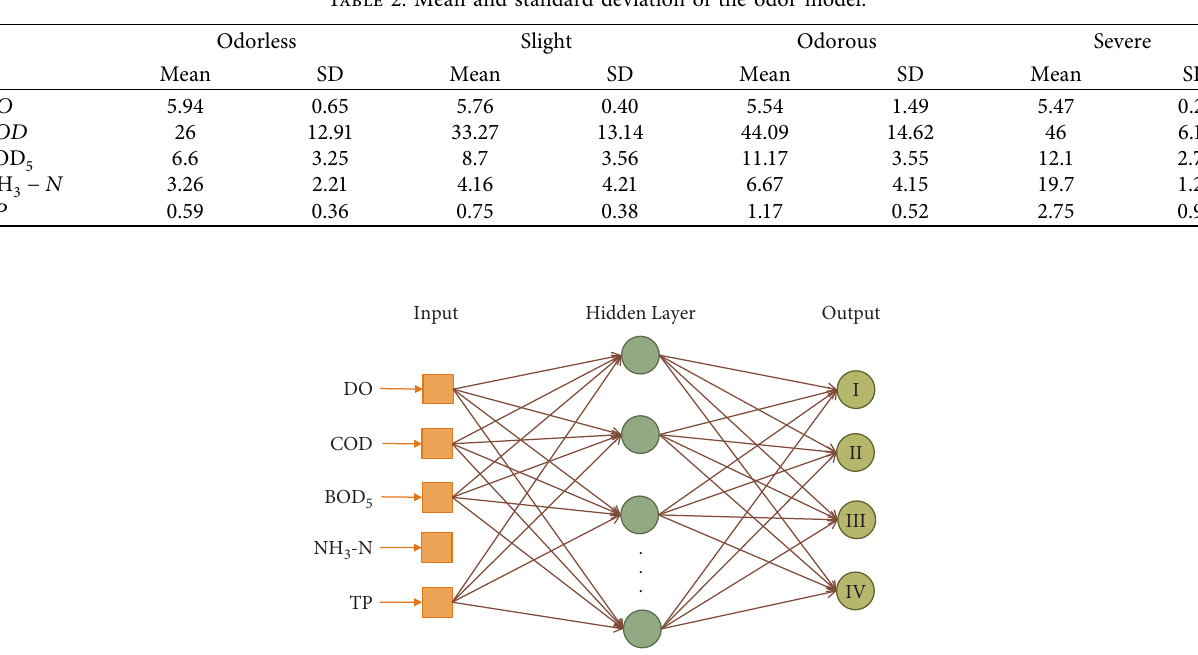
Figure 1: Topology of the color model.